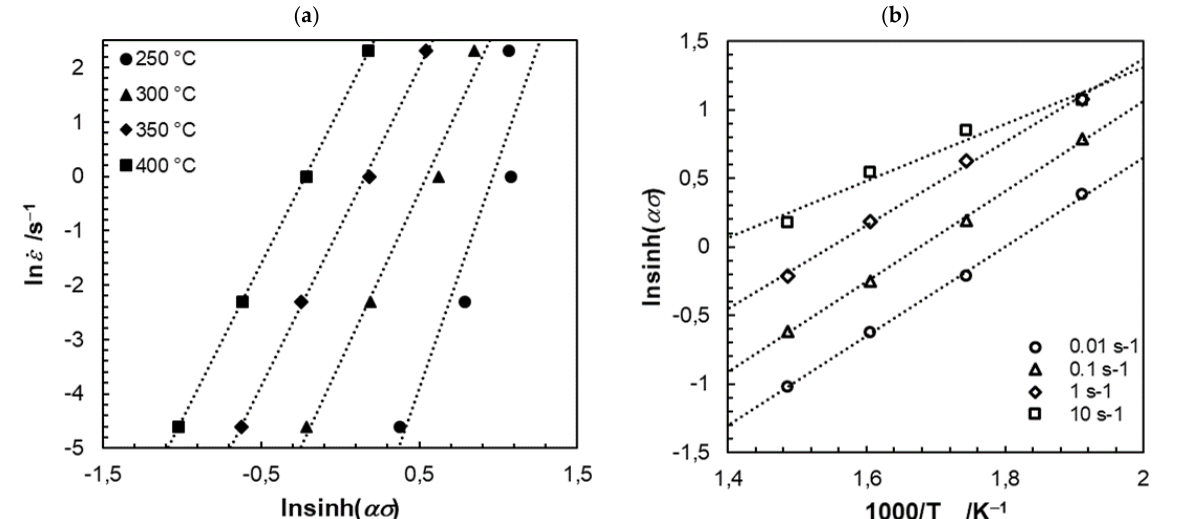
Figure 9. Relationship between of ( a ) ln 𝜀 –ln[sinh( ασ )] and ( b ) ln[sinh( ασ )]–1/T at different strain rates.